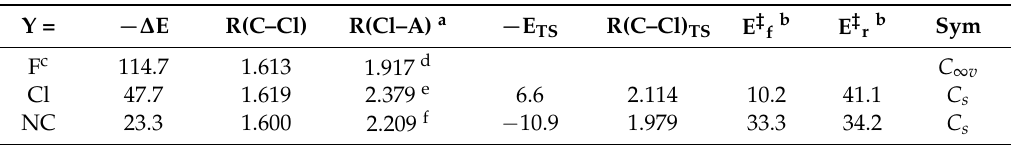
Table 3. Binding energies ( − ∆ E), energies of transition structures (-E TS ), and barriers to the inter-conversion of complex and ion pair (E ‡ f , E ‡ r , kJ . mol − 1 ), C–Cl and Cl–A distances (R, Å), and symmetries of SC–C l+: − Y ion